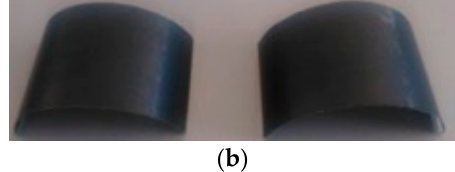
Figure 7. Experimental bistable plates: ( a ) first stable state and ( b ) second stable state.